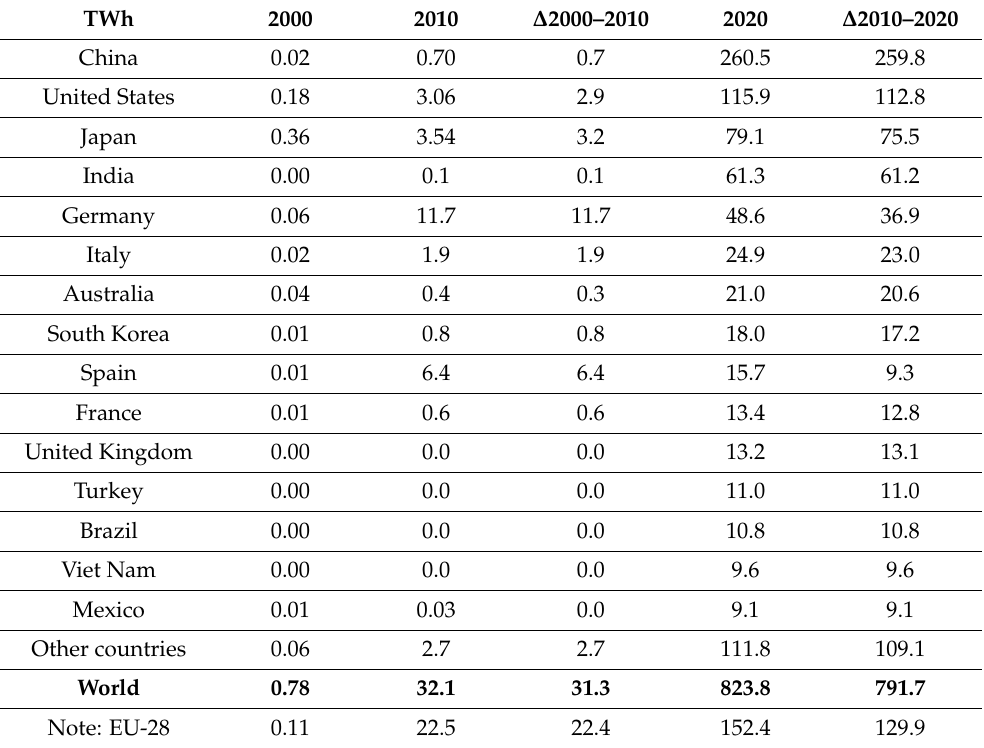
Table 6. Solar PV electricity generation (TWh) (based on [26]).